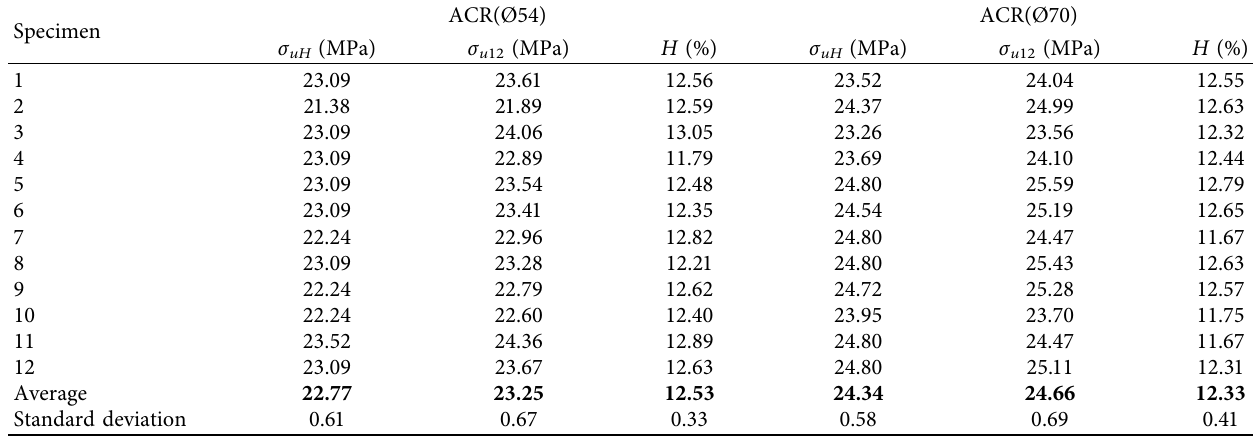
Table 6: Failure stresses in radial compression, diameter 54cm and 70cm.